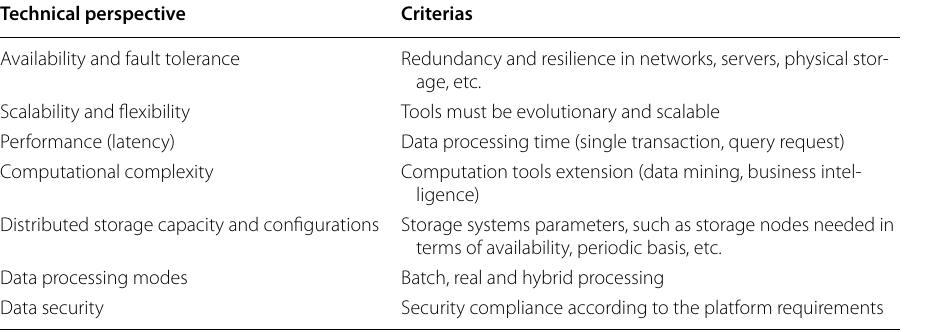
Table 1 AHP model technical perspective Technical perspective Criterias